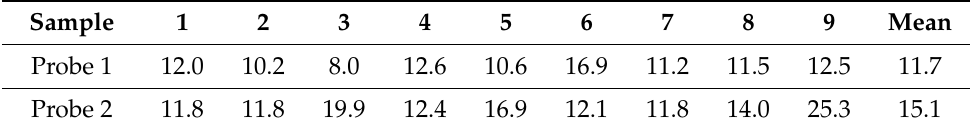
Table 2. Mean ∆ E00 color di ff erence for each sample of both probes: before cleaning vs. after cleaning.